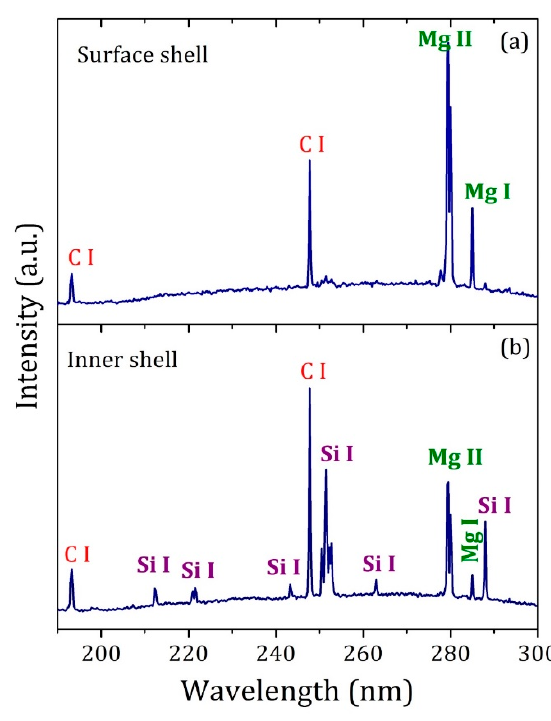
Figure 6. Laser-induced breakdown spectroscopy (LIBS) spectra obtained on the ( a ) surface and ( b ) inside the AE in natura.